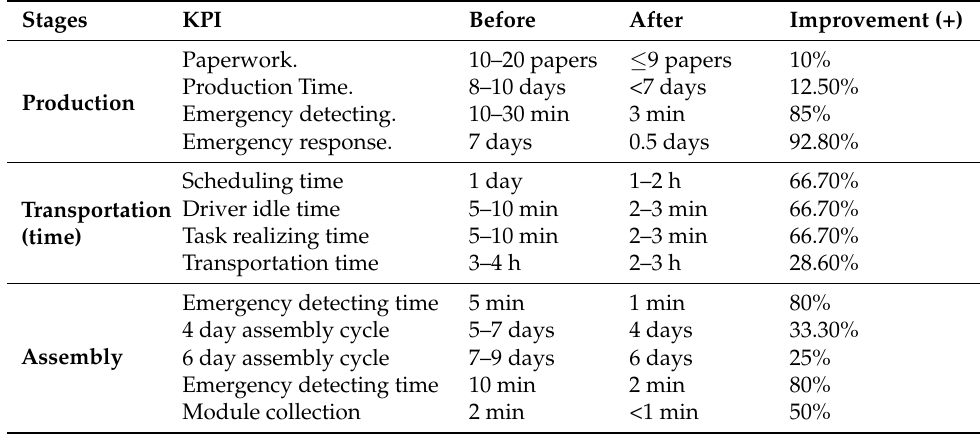
Table 2. Condition analysis of prefabricated module fabrication [39].